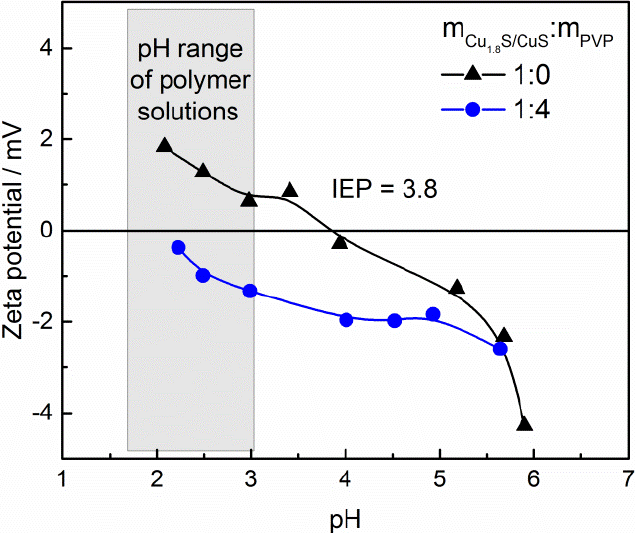
Figure 2. Zeta potential curves for copper sulfides in water and PVP solution (m Cu1.8S/CuS :m PVP = 1:4). Behavior of nanoparticles in polymer solution depends on its pH, viscosity, polymer chain length and presence of functional groups within this chain [41,42]. Molecular weight provided in product specifications of applied polymers was in the range of 50,000 to 190,000 Da for chitosan, for PVP—40,000 Da and for Nafion—100,000 Da. Results